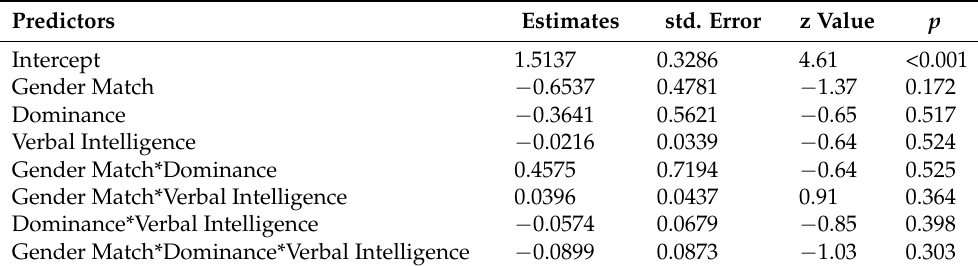
Table A6. Summary of the model for accuracy and the effect of verbal intelligence and language dominance in the production task for the bilingual